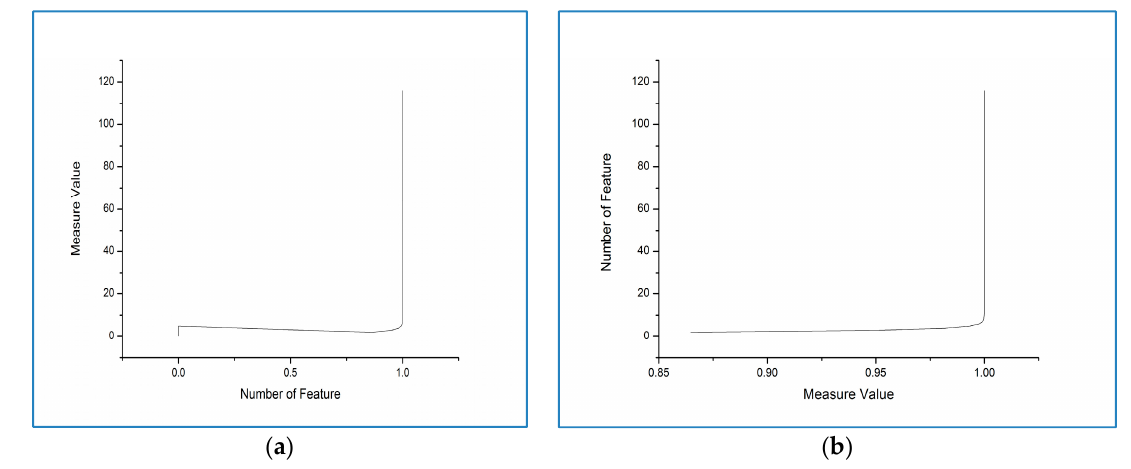
Table 12. Part of the measurement values.